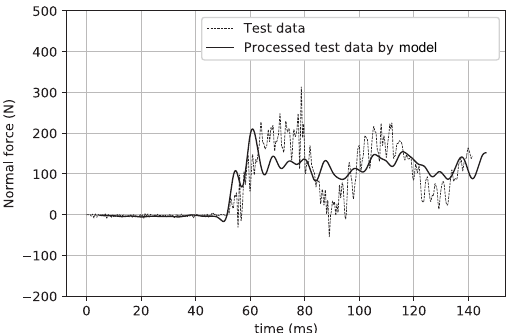
Figure 15. Test data and their processing by the model (normal force).